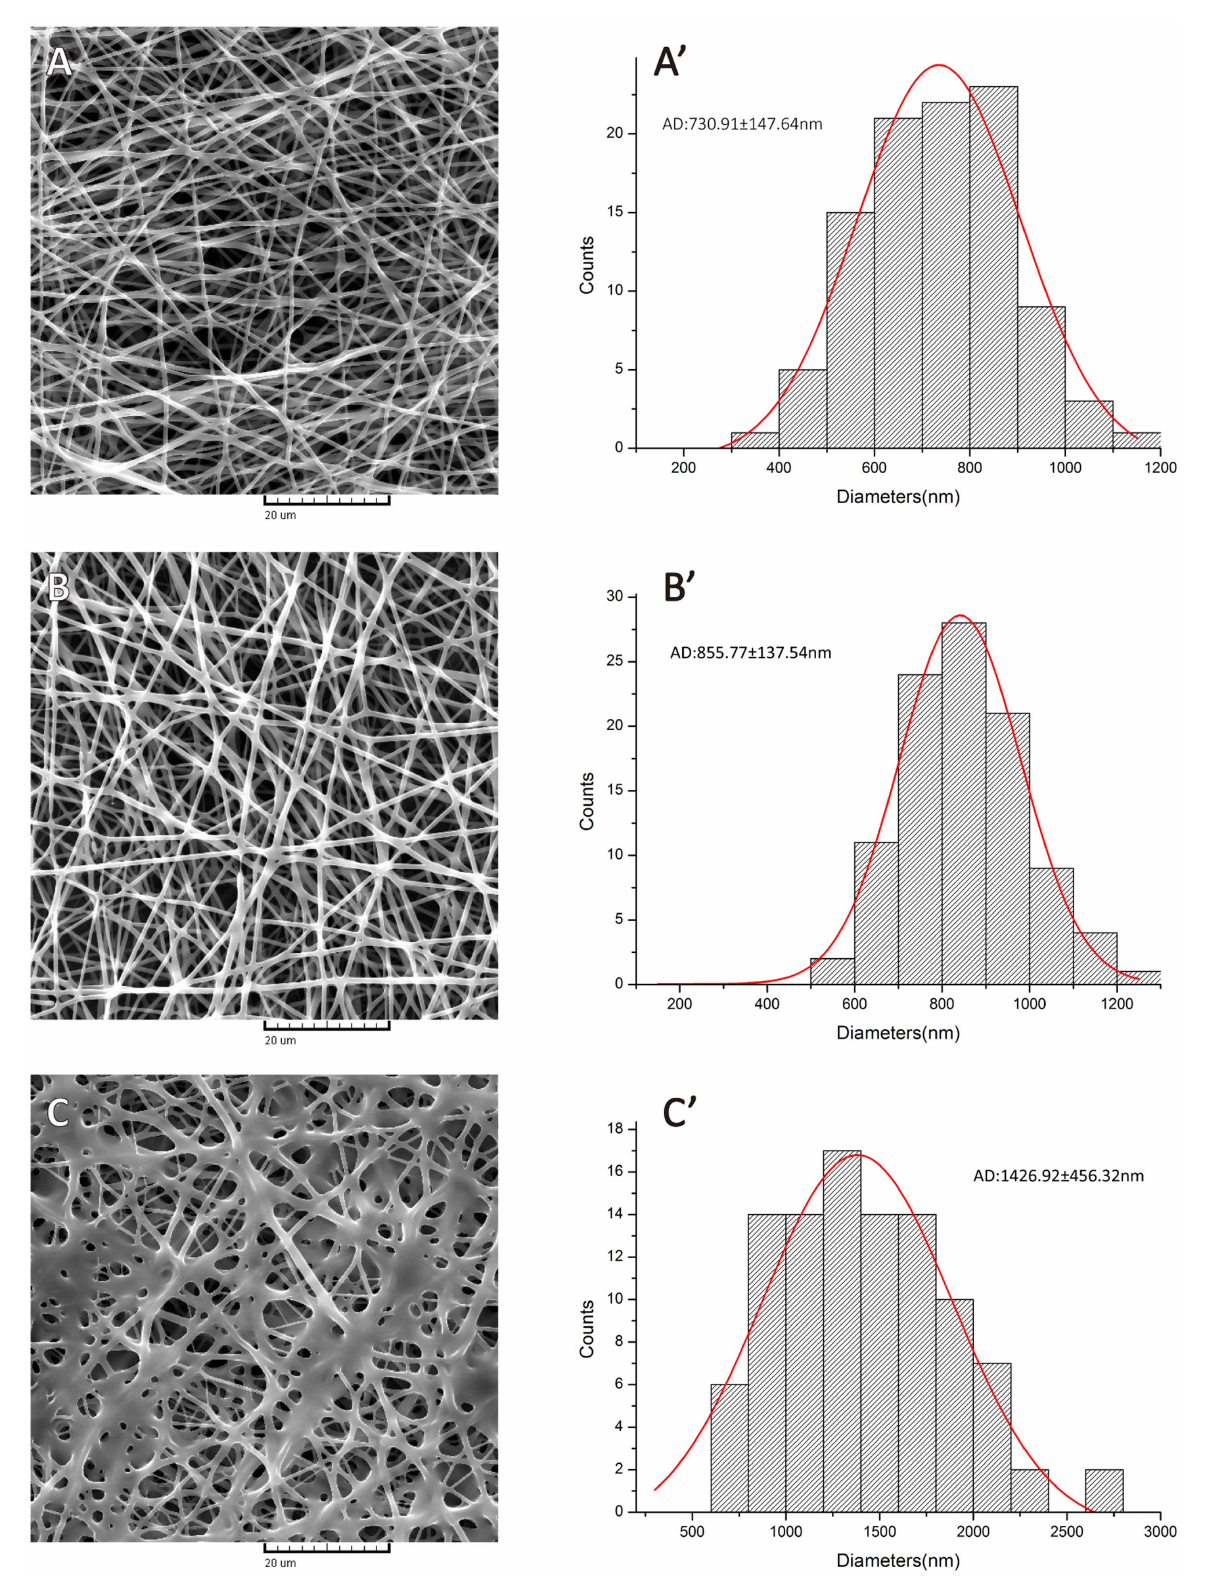
Figure 1. SEM images of electrospun PLCL/Poloxamer nanofibers with different weight ratio of PLCL to Poloxamer: (A) 1/0; (B) 9/1; (C) 3/1.